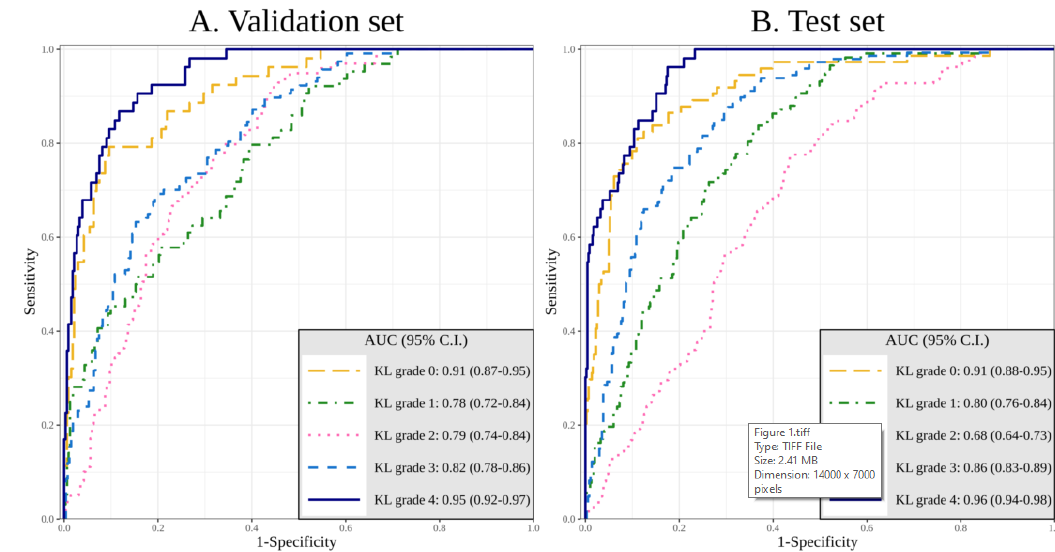
Figure 1. Area under the receiver operating curve (AUC) of the validation set ( A ) and the test set ( B ) for the deep learning (DL) algorithm of Kellgren–Lawrence (KL) grade 0 to 4 with sole image data.